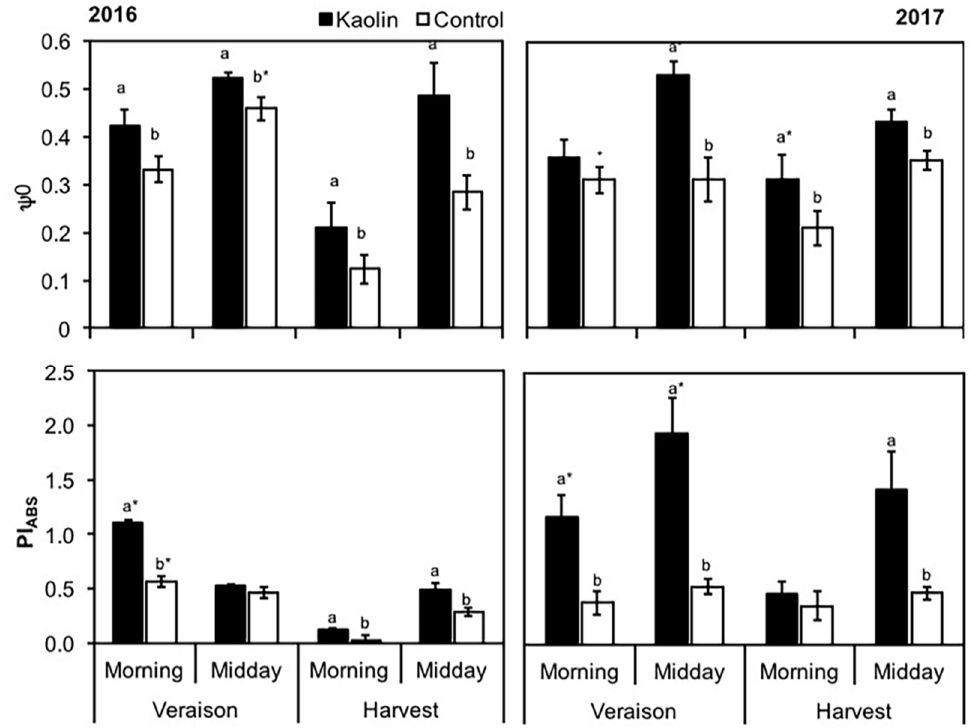
Figure 3. JIP parameters in control and kaolin treated grapevines from veraison and maturation stages in the midday period in 2016 and 2017. Values are presented as mean ± SD ( n = 10). Different lowercase letters represent significant differences between treatments (control vs. kaolin), in the same period of the day (morning/midday) within the stage of the season (veraison/maturation), and * represents significant differences between stages of the season within the same period of the day ( p < 0.05). Absence of superscript indicates no significant differences.